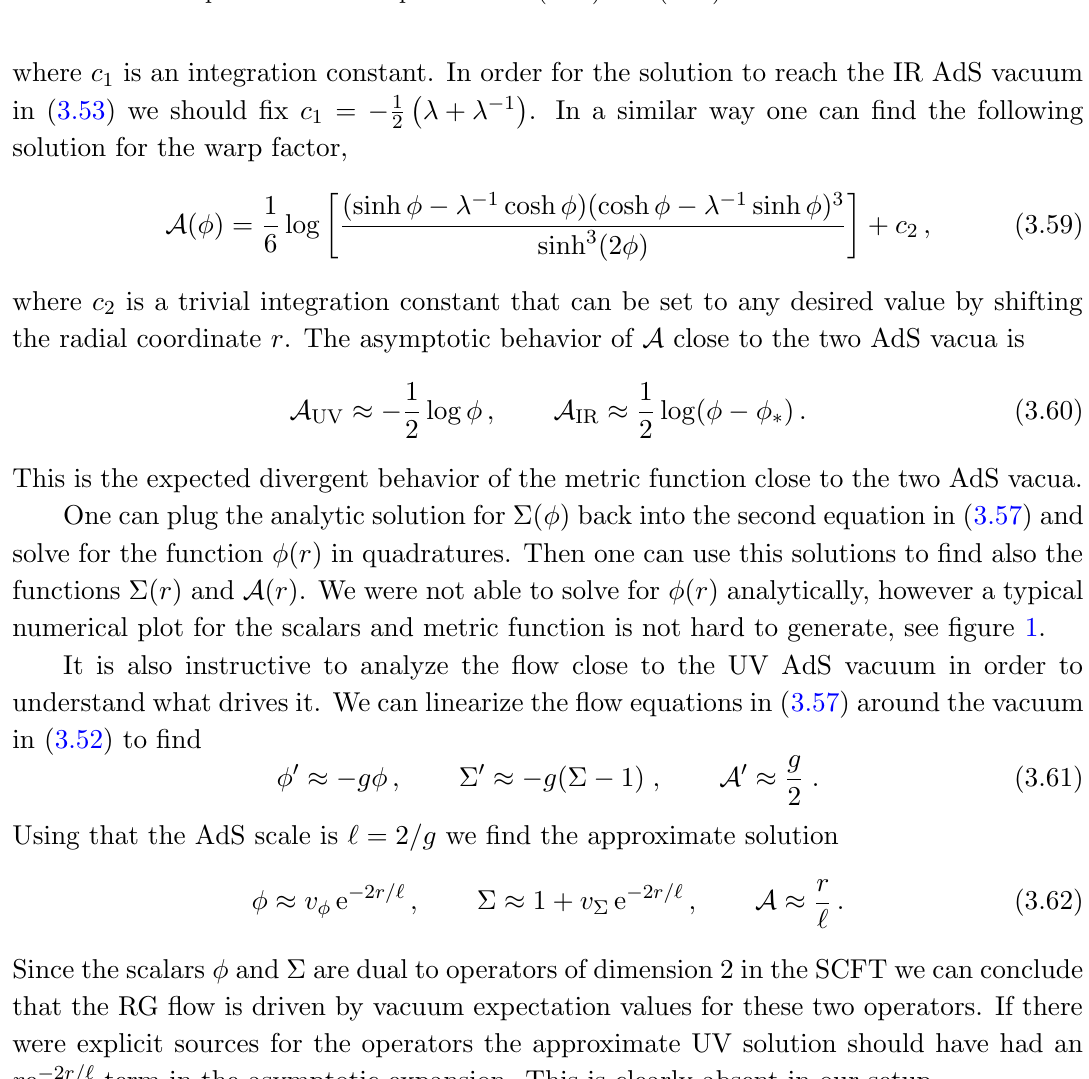
Figure 1 . Left : numerical solutions for (cid:30) ( r ) (red solid line) and (cid:6)( r ) (blue solid line). The dashed red/blue lines are the values for the scalars at the IR vacuum in (3.53). We have (cid:12)xed g = 1 and (cid:21) (cid:0) 1 = 1 : 1. Right : numerical solution for A ( r ) for the same values of g and (cid:21) . The IR/UV is at large negative/positive values of r . The function A ( r ) is linear in these regions and the scalars attain their (cid:12)xed point values as expected from (3.52) and